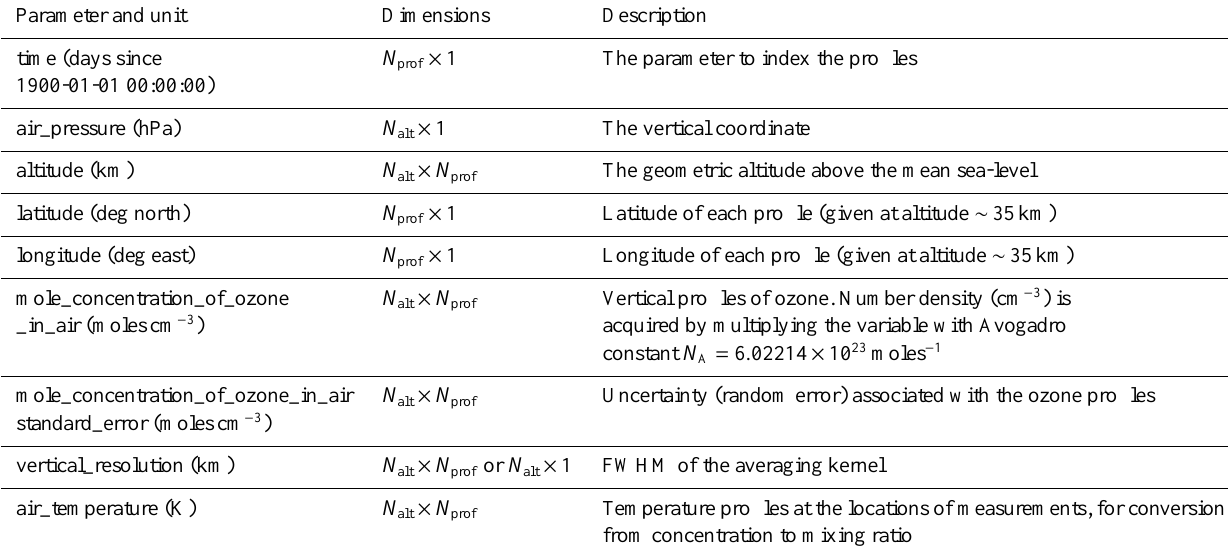
Table 2. Mandatory parameters in the HARMOZ netCDF files. N alt and N prof denote the number of pressure levels and the number of profiles,